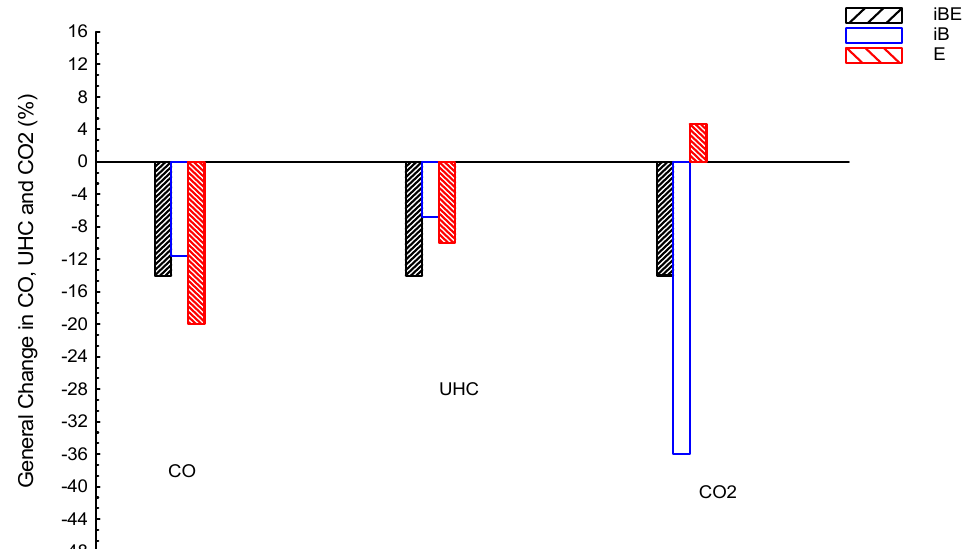
Figure 12. CO, CO 2 , and UHC emissions averages for blended fuels of iso-butanol–bio-ethanol–gasoline (iBE), iso-butanol–gasoline (iB), and bio-ethanol–gasoline (E); gasoline is the reference line.